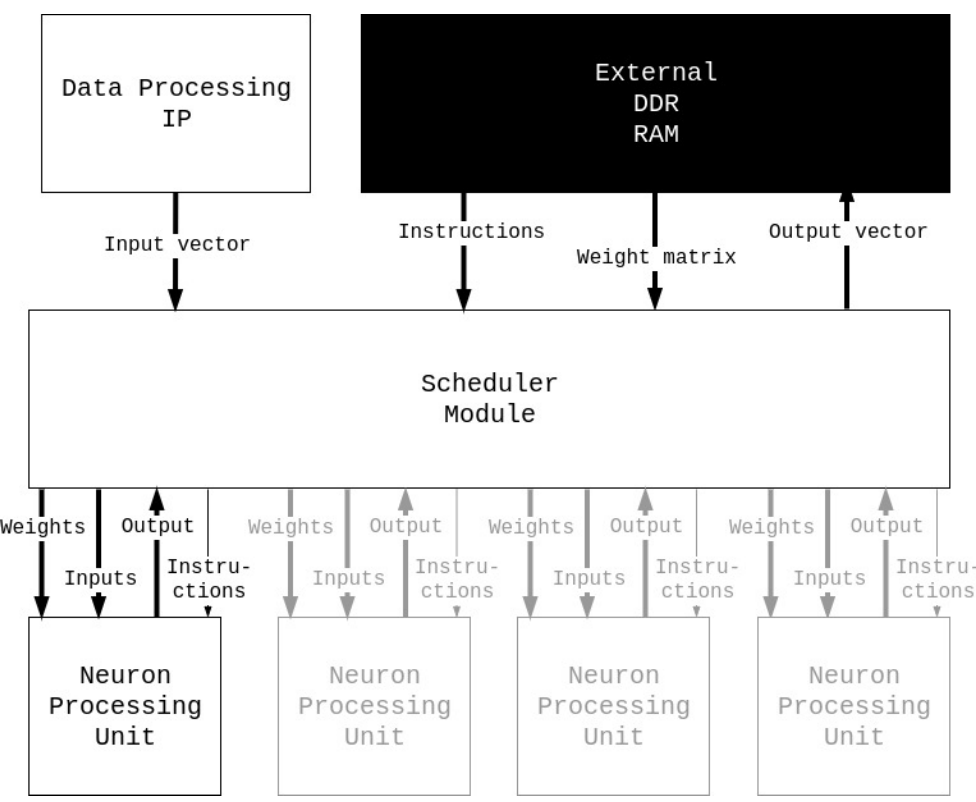
Figure 4. Four cores Neural Network Processor (NNP)